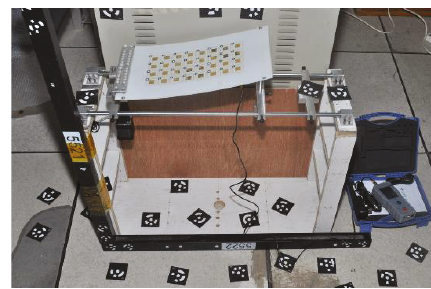
Figure 13: Testing experiment of material